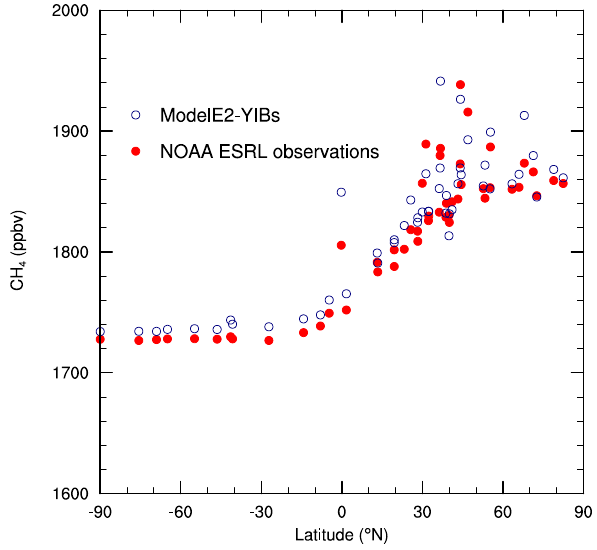
Figure 4. Annual-mean surface methane concentration (ppbv) at 50 locations for both the E2005 simulation and the NOAA ESRL